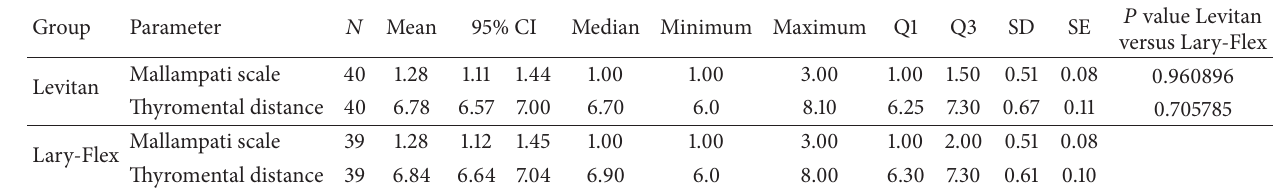
Table 3: Evaluation of preintubation conditions data of studied groups.